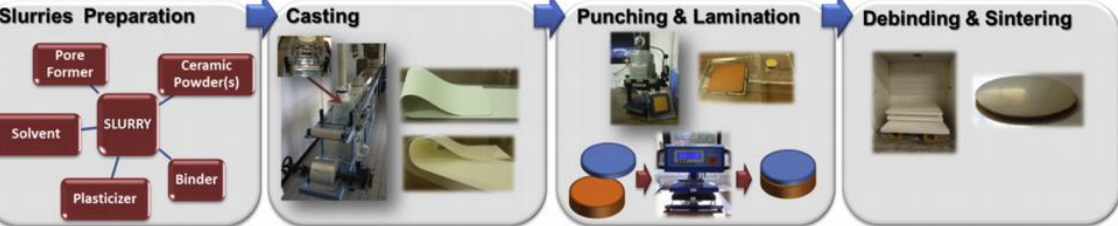
Figure 13. The preparation procedure of the asymmetric BCZY-GDC dual-phase membrane